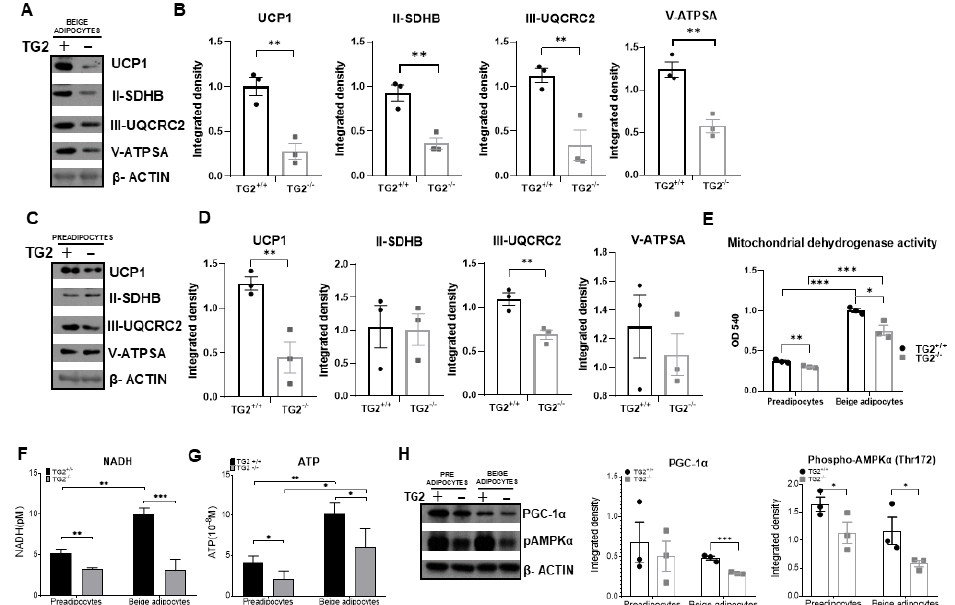
Figure 2. Detection of UCP1 and mitochondrial complex proteins and the levels of NADH and ATP in TG2 +/+ and TG2 − / − cells together with PGC1 α and pAMPK expressions: ( A ) Representative Western blots of UCP1, II-SDHB, III-UQCRC2, V-ATPSA of beige cells ( n = 3); ( B ) quantitative analyses of Western blots of UCP1, II-SDHB, III-UQCRC2, and V-ATPSA proteins ( n = 3); ( C ) representative Western blots of UCP1, II-SDHB, III-UQCRC2, and V-ATPSA of preadipocytes ( n = 3); ( D ) quantitative analyses of Western blots of UCP1, II-SDHB, III-UQCRC2, and V-ATPSA proteins of preadipocytes; ( E ) mitochondrial dehydrogenases activity levels in preadipocytes and differentiated beige cells (MTT assays, n = 3); ( F ) NADH and ( G ) ATP content of preadipocytes and beige cells; ( H ) representative Western blots and quantitative analyses of phospho-AMPK α and PGC-1 α in preadipocytes and beige cells. β -ACTIN was used as a loading control. Columns represent the mean values ± SD. Statistical analyses were performed using Student’s t -test. *, **, and *** indicate statistically significant differences at p < 0.05, p < 0.01, or p < 0.001, respectively. n = 3.